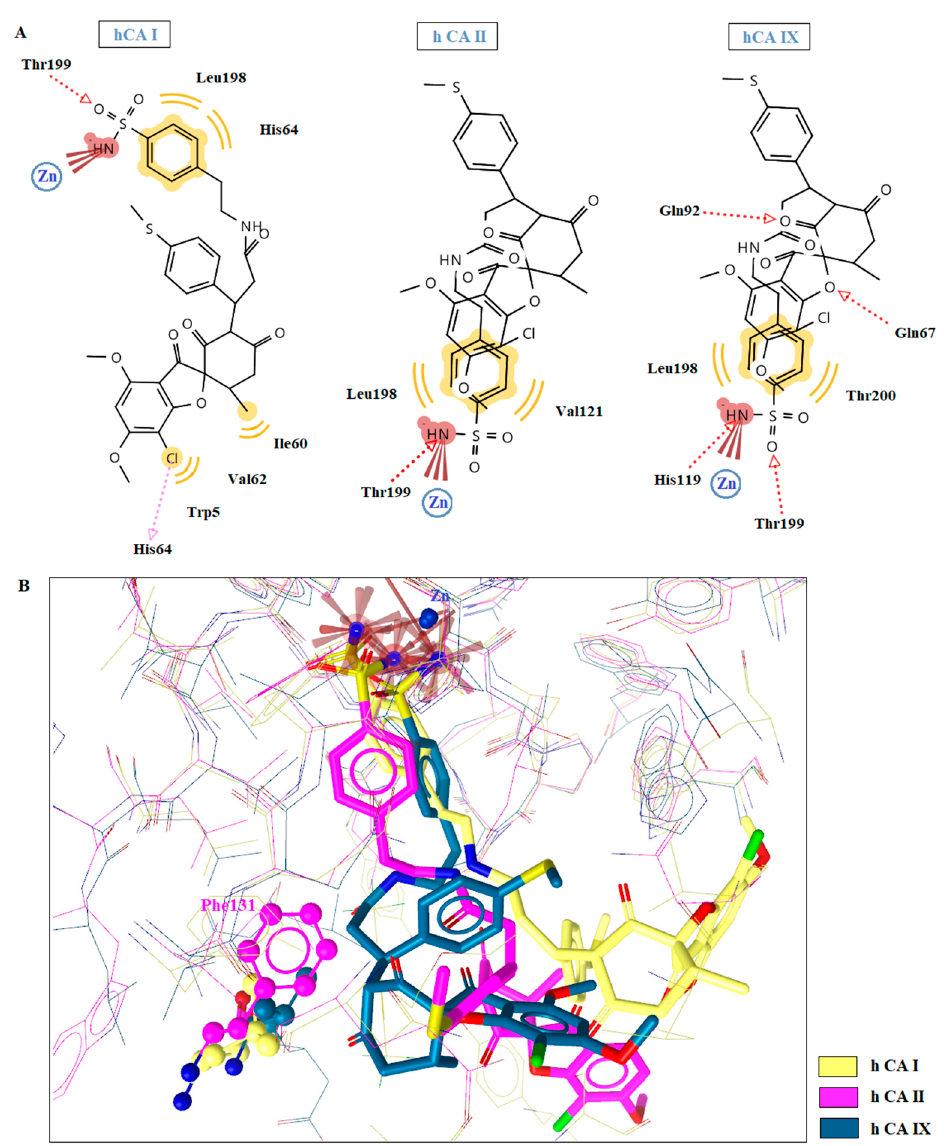
Figure 3. ( A ) 2D interaction diagram of compound 1i docking pose interactions with the key amino acids in hCA I, hCA II, and hCA IX ( B ) Superposition of compound 1i (yellow)bound to hCA I in comparison with its binding to hCA II (magenta) and hCA IX (blue) isoforms. Active site zinc shown as blue sphere, red dotted arrows indicate H-bonds, pink arrow halogen bond and yellow spheres hydrophobic interactions.